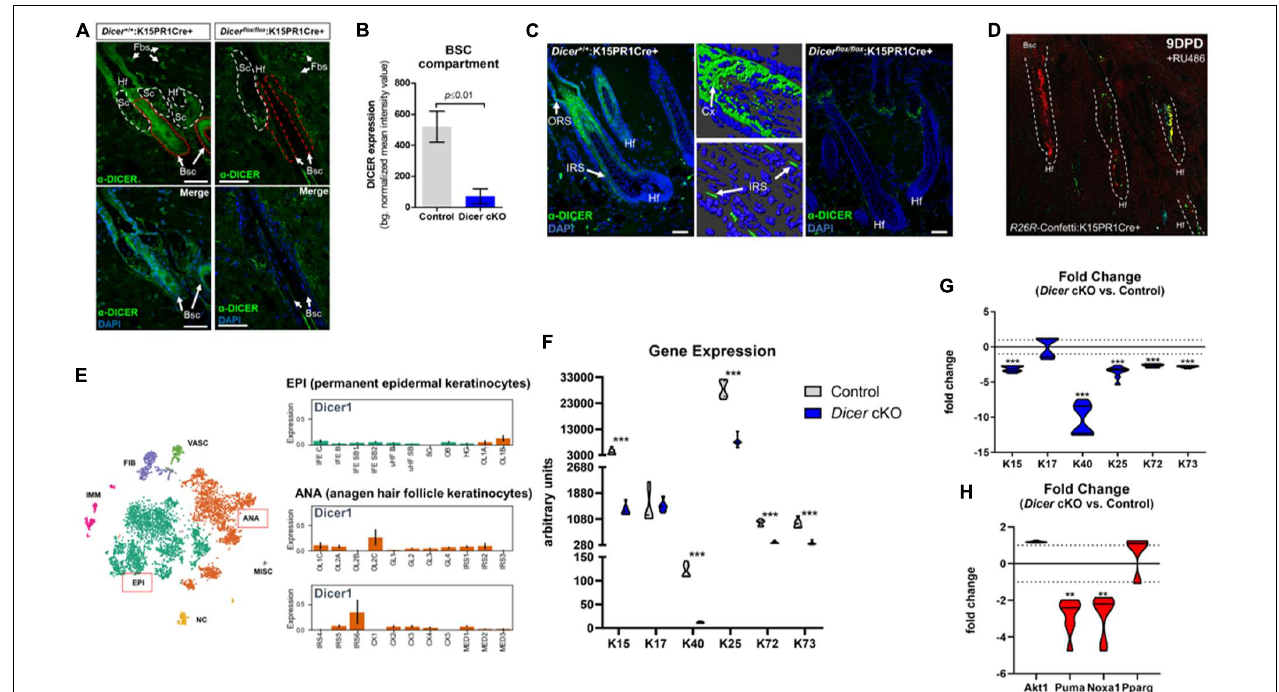
FIGURE 3 | Conditional ablation of Dicer within K15-postiive bulge stem cells impairs hair follicle differentiation. (A) Immunofluorescence detection of DICER within various hair follicle compartments of control ( Dicer + / + ;K15PR1Cre+) and experimental ( Dicer flox / flox ;K15PR1Cre+) skin. Upper panels depict the individual compartments and cell types that express or do not express DICER. Hf (hair follicle), Sc (sebaceous gland compartment; white dash), Fbs (fibroblasts), Bsc (bulge stem cell compartment; red dash). The lower panels highlight only the Bsc and nuclear staining with DAPI. Bars = 50 um (Right panel). (B) Quantification of DICER expression from immunofluorescence staining. DICER expression was analyzed within bulge stem cell compartments ( n = 8; p ≤ 0.01, Student’s t test) and presented as background normalized mean intensity values. (C) Immunofluorescence detection of DICER within the entire hair follicle of control ( Dicer + / + ;K15PR1Cre+) and experimental ( Dicer flox / flox ;K15PR1Cre+) skin. Right panels depict 3D-rendered models of DICER expression in control hair follicles (Bars = 25 um). ORS (outer root sheath), IRS (inner root sheath), Cx (cortex). Bars = 50 um. (D) K15 BSC lineage tracing using the R26R -Confetti:K15PR1Cre+ mouse line. (E) Dicer mRNA expression at the single cell level during hair growth (anagen) and rest (telogen) in full-thickness skin. Main cell population distribution shown in the upper panel using the T-distributed Stochastic Neighbor Embedding (t-SNE) technique. Permanent epidermis keratinocytes (shown in green, boxed in red) contain subpopulations of resting BSCs and epidermal keratinocytes. The anagen hair follicle keratinocytes (shown in orange, boxed in red) contain subpopulations of cells undergoing growth and differentiation. EPI (permanent epidermal keratinocytes), ANA (anagen hair follicle keratinocytes), VASC (vascular cells), FIB (fibroblast-like cells), IMM (immune cells), NC (neural crest-derived cells), MISC (miscellaneous). The lower panel shows Dicer1 expression in log2 scale on the y -axis within subpopulation of EPI and ANA cells. EPI cells consist of interfollicular epidermis (IFE) basal cycling (C), basal (B) and suprabasal (SB) cells, upper hair follicle (uHF) basal (B) and suprabasal (SB) cells, sebaceous glands (SG), outer bulge (OB), and hair germ (HG) cells. ANA cells consist of outer layer (OL) cells, germinative layer (GL) cells, inner root sheath (IRS) cells, cortex/cuticle (CX) cells, and medulla (MED) cells. Data derived from: (Joost et al., 2020). (F) Arbitrary keratin gene expression using real-time PCR. Gene expression presented as arbitrary units for individual genes and samples ( n = 3; *** p ≤ 0.001, two-way ANOVA). (G) Fold change in keratin gene expression. Fold change in gene expression comparing Dicer cKO versus control. Dotted line is no change in gene expression ( n = 3; *** p ≤ 0.001, two-way ANOVA). (H) Fold change in apoptosis, pro-survival and sebaceous gland gene expression. Fold change in gene expression comparing Dicer cKO versus control. Dotted line is no change in gene expression ( n = 3; ** p ≤ 0.01, two-way